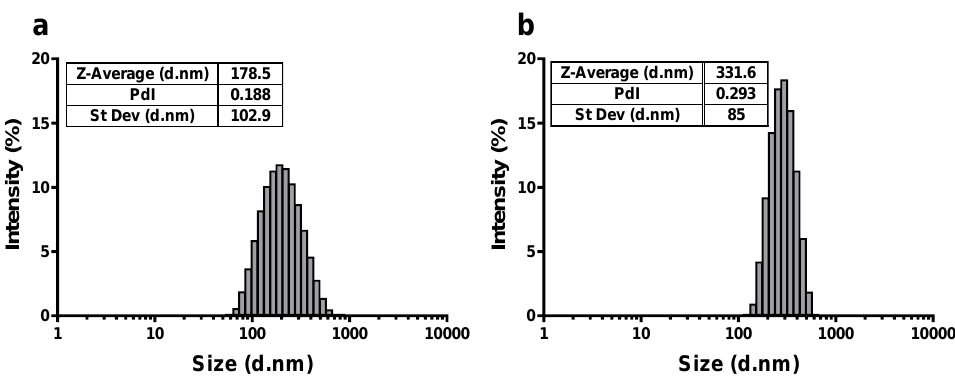
Figure 2. Average size distribution measured by dynamic light scattering: ( a ) GP1 and ( b ) GP2 in 0.02% sodium cholate; PdI: polydispersity index; Z-average: R h ; St Dev: standard deviation